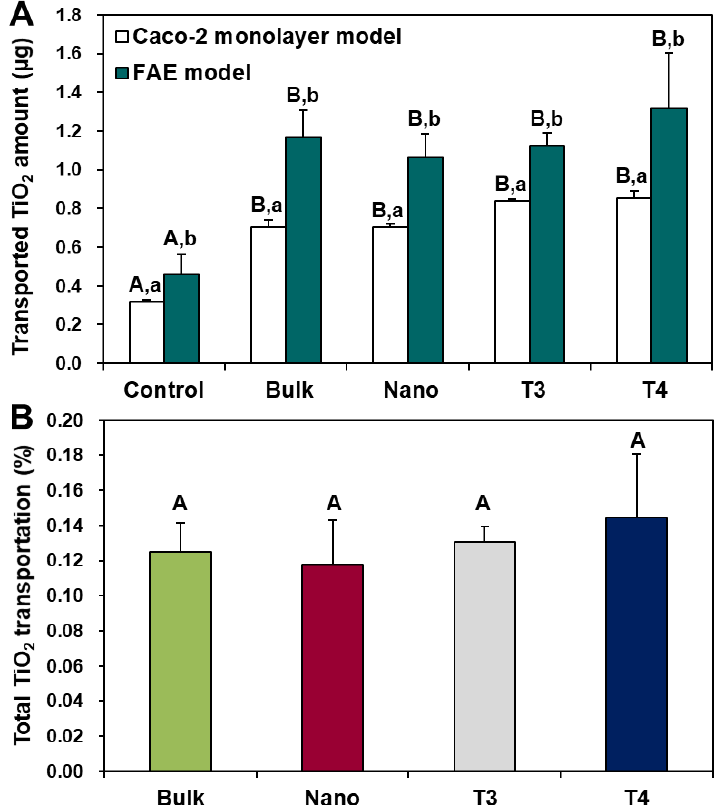
Figure 9. Intestinal transport mechanism of TiO 2 particles using ( A ) in vitro models of Caco-2 monolayer and human follicle-associated epithelium (FAE). ( B ) Total combined intestinal transport amount of TiO 2 particles through both Caco-2 monolayer and FAE models. Different uppercase letters (A, B) indicate significant differences among control (cells without particles) and different TiO 2 particles (food-grade T3, T4, general-grade bulk and nano) ( p < 0.05). Different lowercase letters (a, b) indicate significant differences between Caco-2 monolayer and FAE models ( p < 0.05).